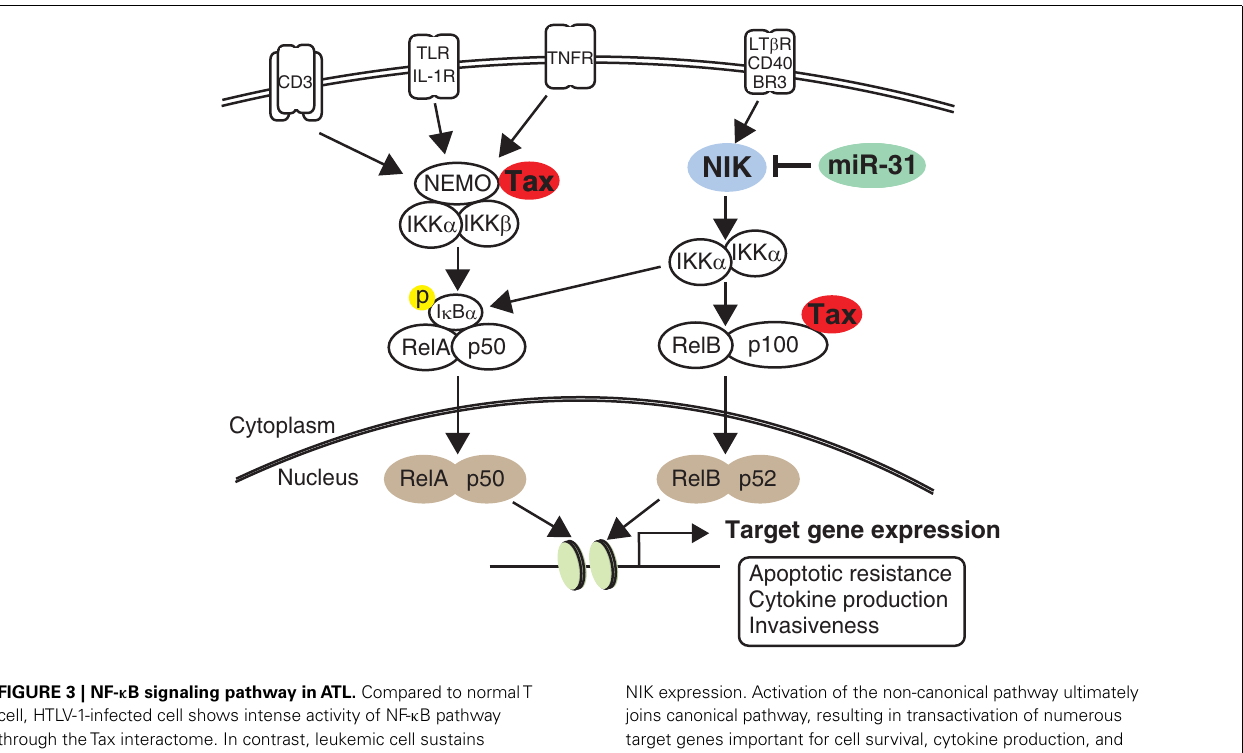
FIGURE 3 | NF- κ B signaling pathway inATL. Compared to normalT cell, HTLV-1-infected cell shows intense activity of NF- κ B pathway through theTax interactome. In contrast, leukemic cell sustains strong NF- κ B activity withoutTax by acquisition of miR-31-dependent